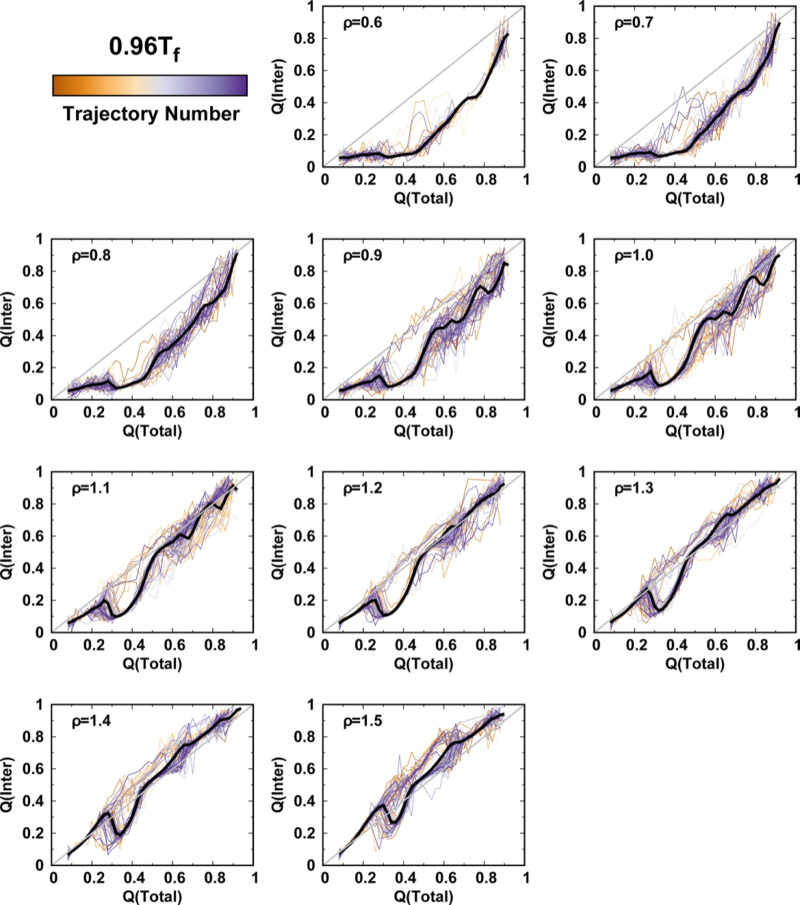
Averaged Q⁢(Inter) and Q⁢(Total) at a temperature 0.96⁢Tf for different values of ρ.One hundred independent simulations starting from different unfolded states of DPO4 for each value of ρ.